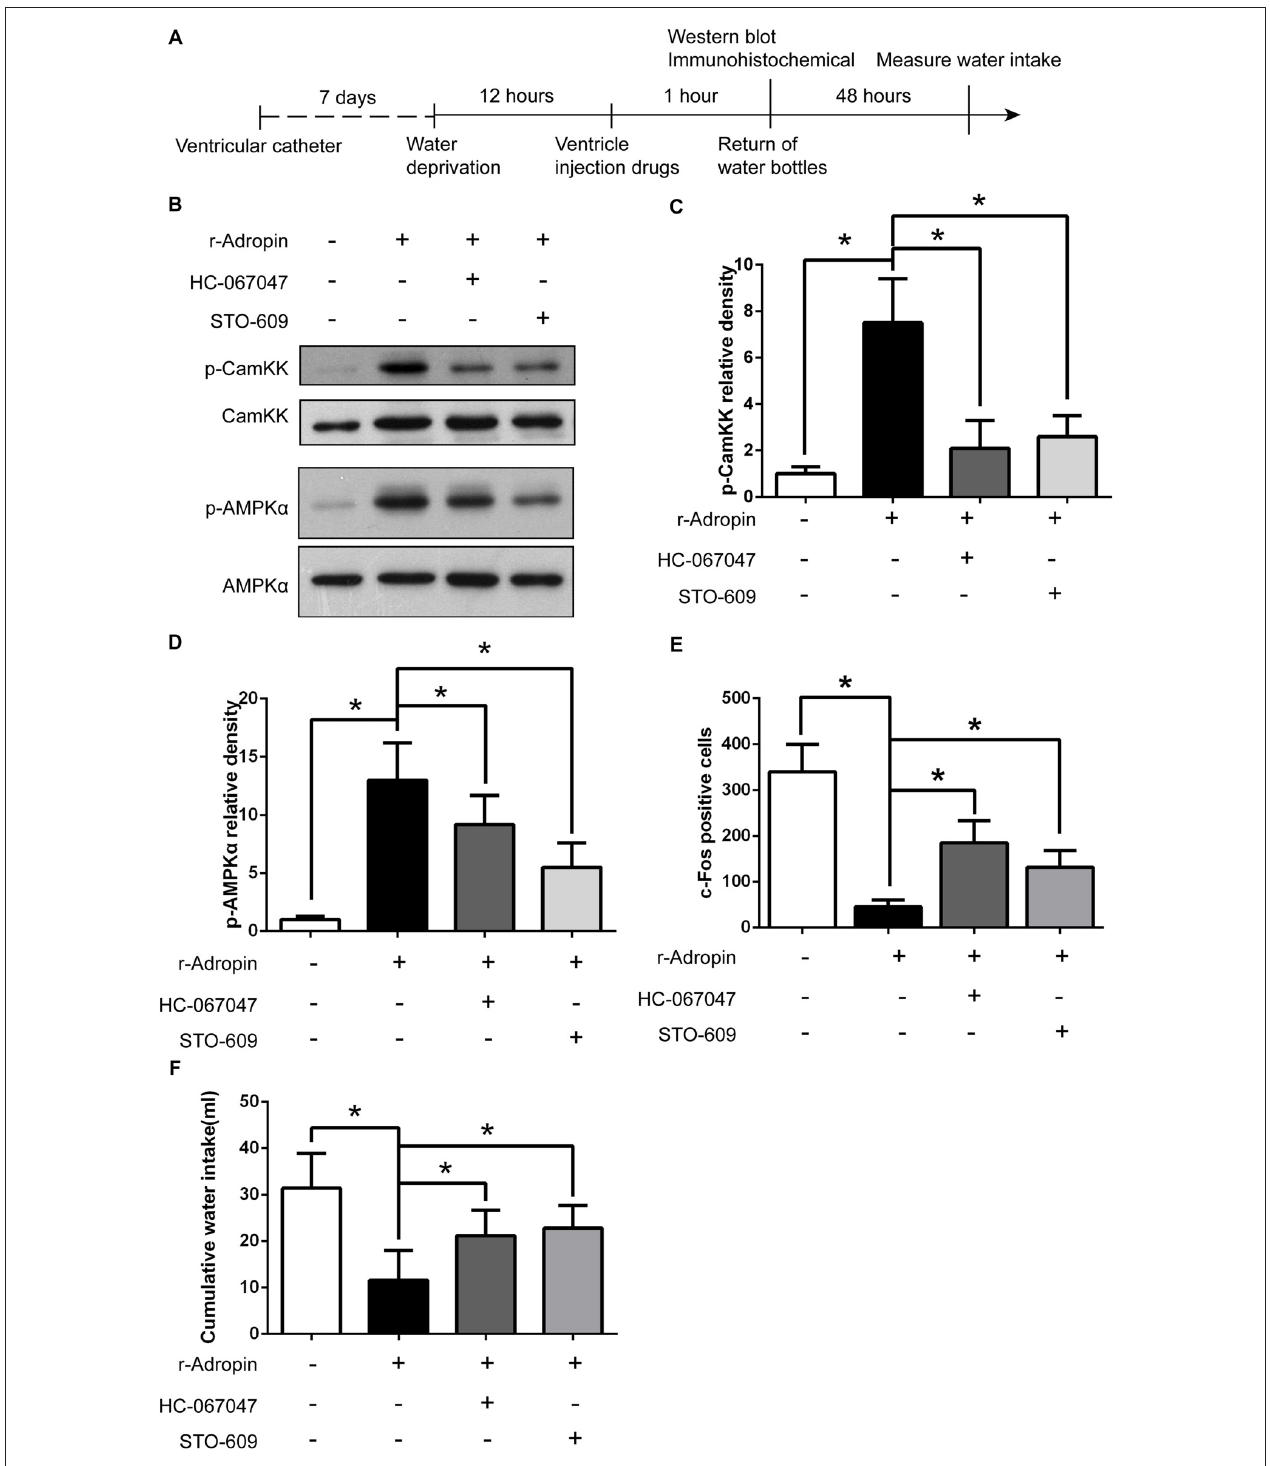
FIGURE 5 | The anti-dipsogenic effects of recombinant adropin was regulated by TRPV4-Camkk-AMPK pathway under normoxic condition in SFO. (A) The experimental design to study the mechanism. (B) p-Camkk and p-AMPK in SFO were detected 1 h after central injection of 3 nM recombinant adropin or 1 mM HC067047 or 1.5 mM STO-609 (a Camkk inhibitor) in overnight water-deprived rats. (C,D) Relative p-Camkk and p-AMPK protein expression was calculated ( n = 6 for each group; ∗ P < 0.05). (E) c-Fos positive cells in SFO was counted 1 h after central injection of drugs in overnight water-deprived rats ( n = 3 for each group; ∗ P < 0.05). (F) Cumulative water intake within 48 h after central injection of drugs in overnight water-deprived rats ( n = 8 for each group; ∗ P < 0.05).